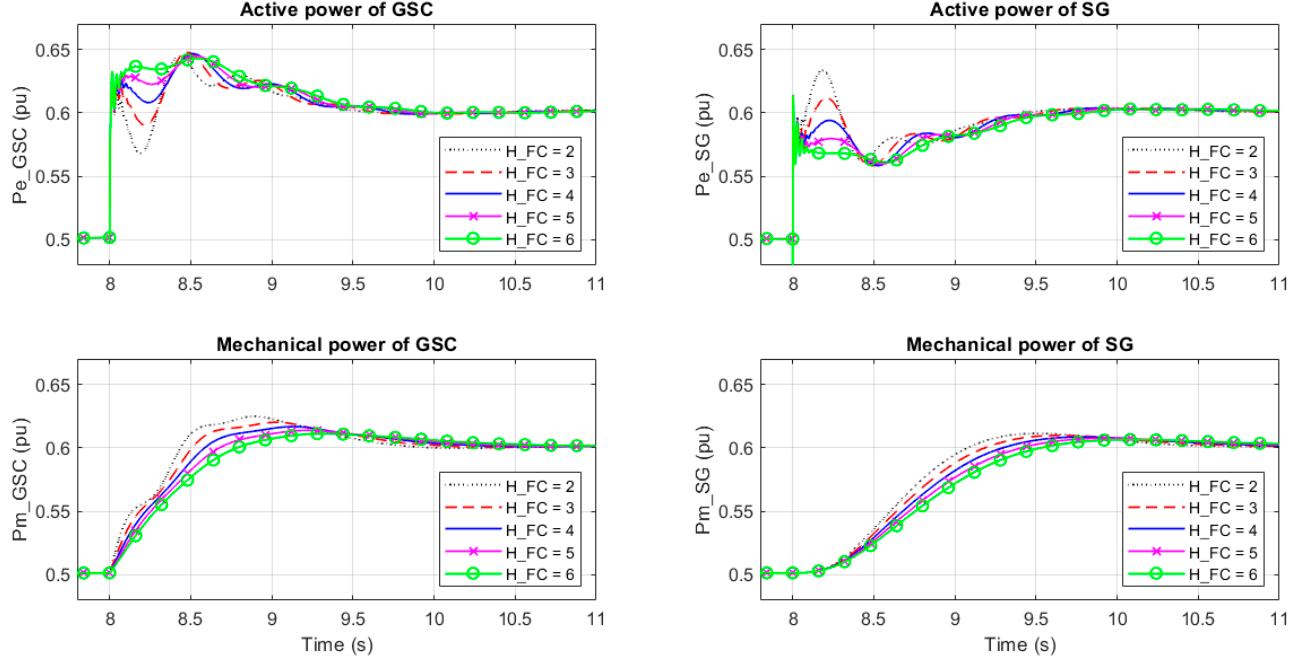
Figure 4. Influence of the inertia constant H on the system’s response (H_SG = 4 W·s/VA, D r _ FC = D r _ SG =